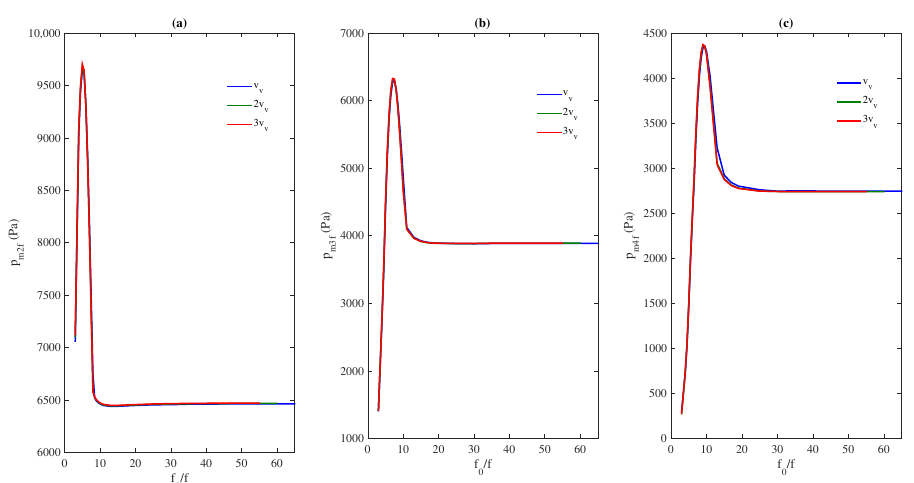
Figure 7. Maximum amplitude of 2 f ( a ), 3 f ( b ), and 4 f ( c ) in the cavity of length L = 16 λ vs. f 0 / f , for three different void fractions v v (blue line), 2 v v (green line), and 3 v v (red line).